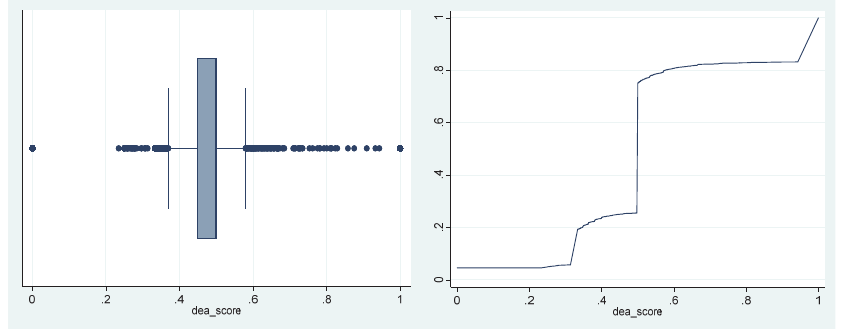
Fig. 1. Distribution about technical efficiency of farms